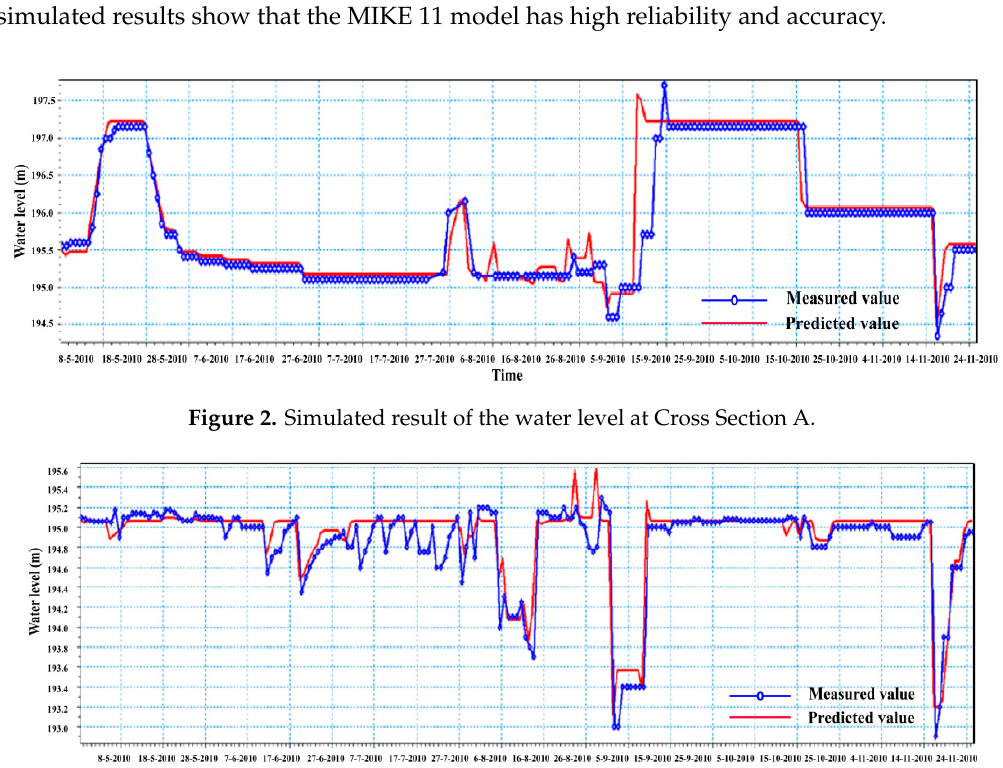
Figure 3. Simulated result of the water level at Cross Section B.